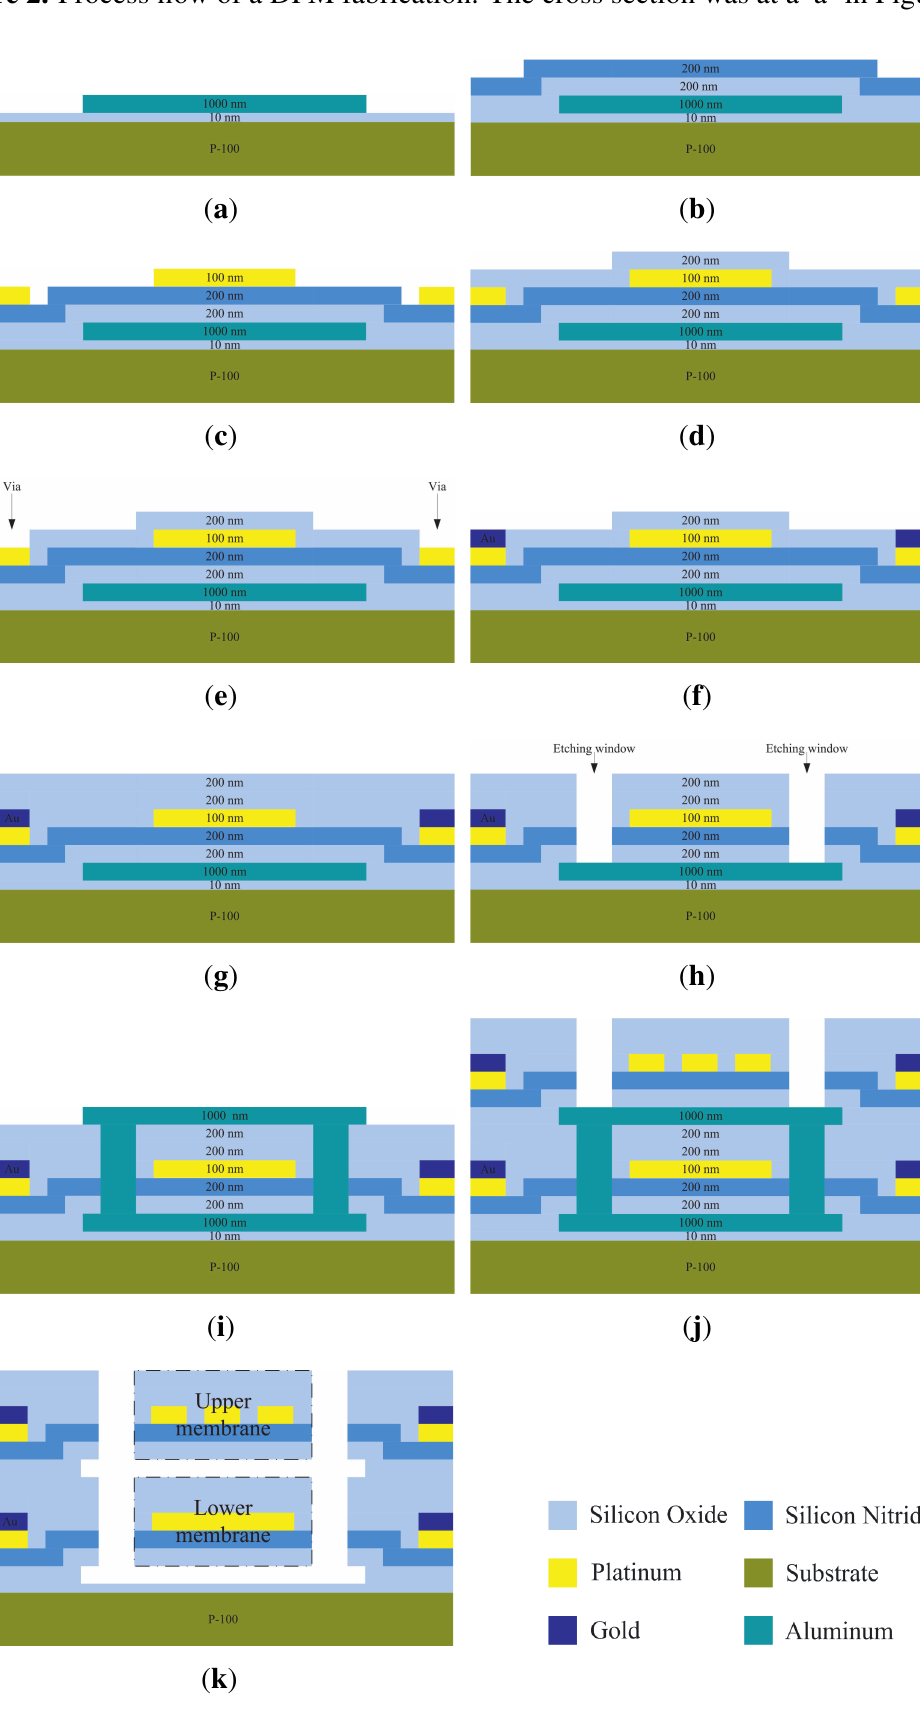
Figure 2. Process flow of a DFM fabrication. The cross section was at a–a’ in Figure